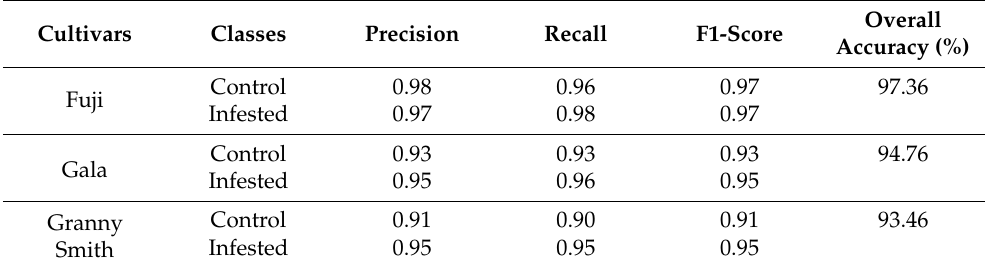
Table 4. Classification performance of gradient tree boosting for control and infested samples for three apple cultivars based on automatically selected pixels for three apple